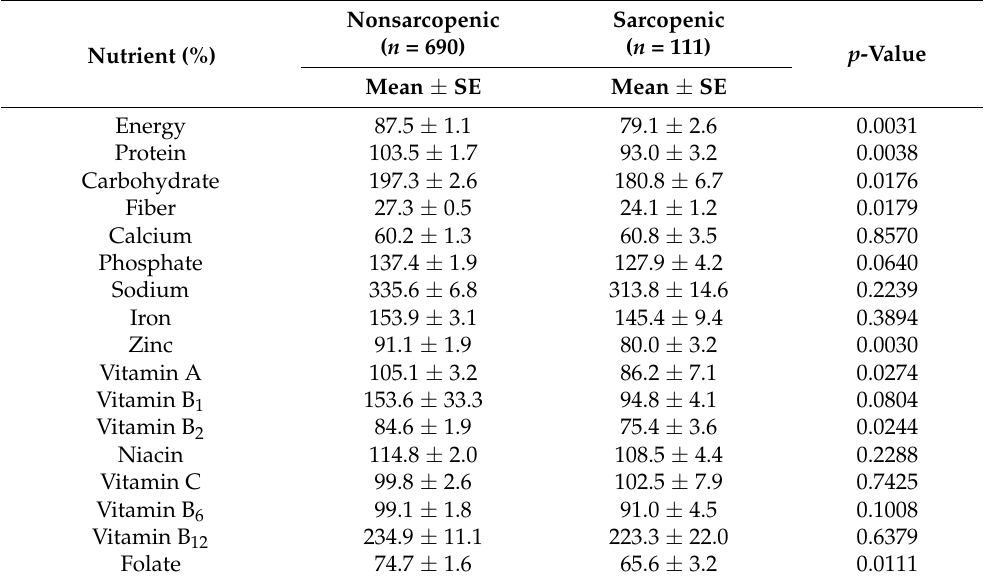
Table 4. Comparison of nutrient intake percentages of the 2020 Dietary Reference Intakes for Koreans (KDRIs) (1) .